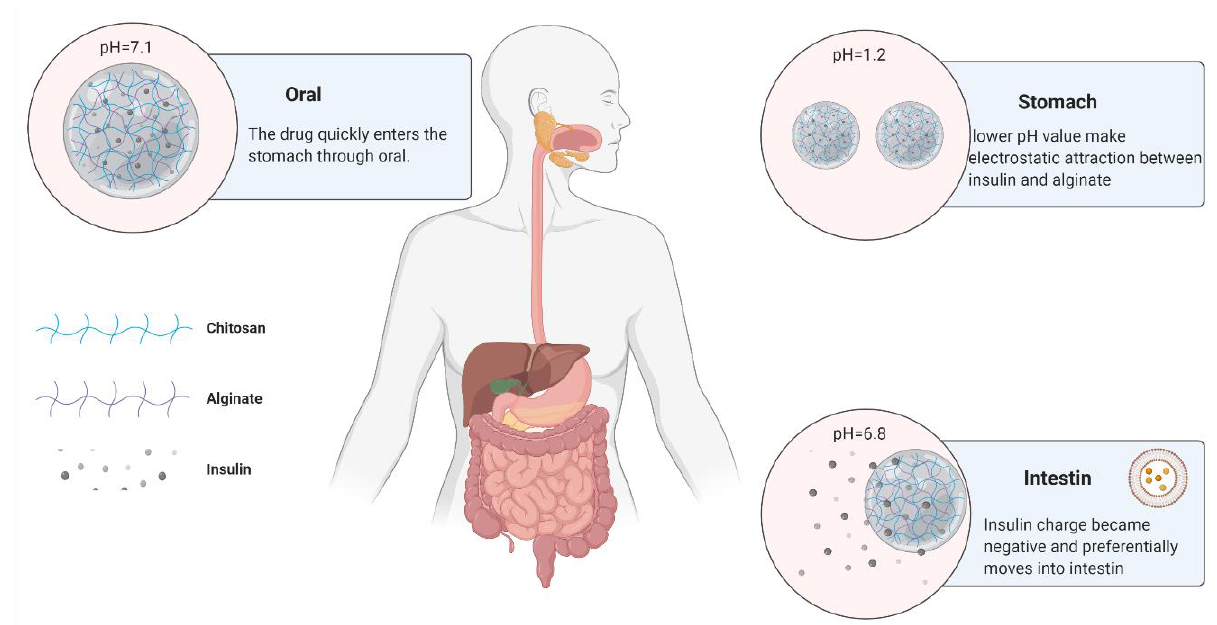
Figure 7. Use of chitosan and alginate to protect insulin.